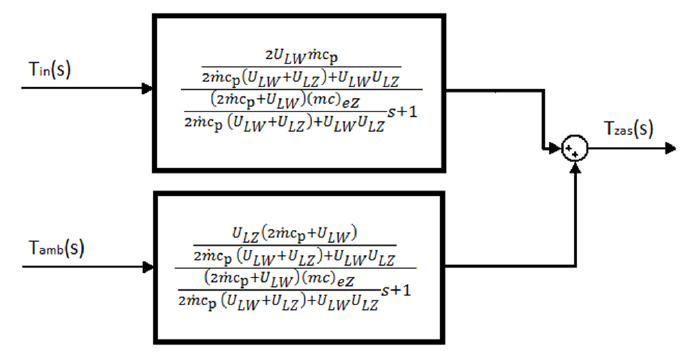
Figure 2. Block diagram of a domestic hot water storage tank